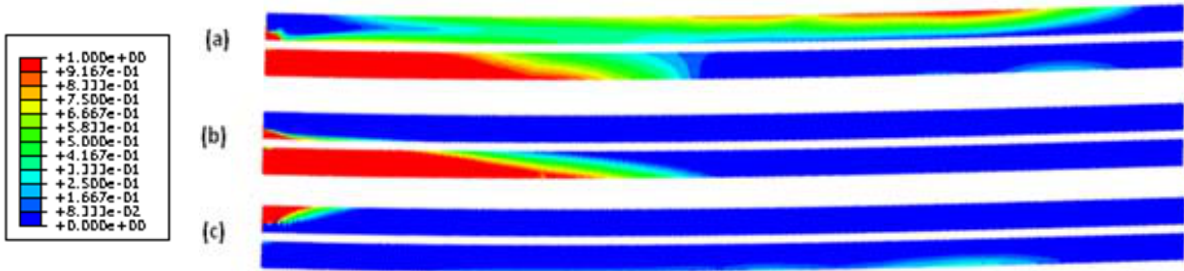
Figure 5. Contour plots of damage in laminated glass at 3.4 ms after impact for large missile with round end configuration: ( a ) web-shaped damage D D ; ( c ) shear damage D 33 12